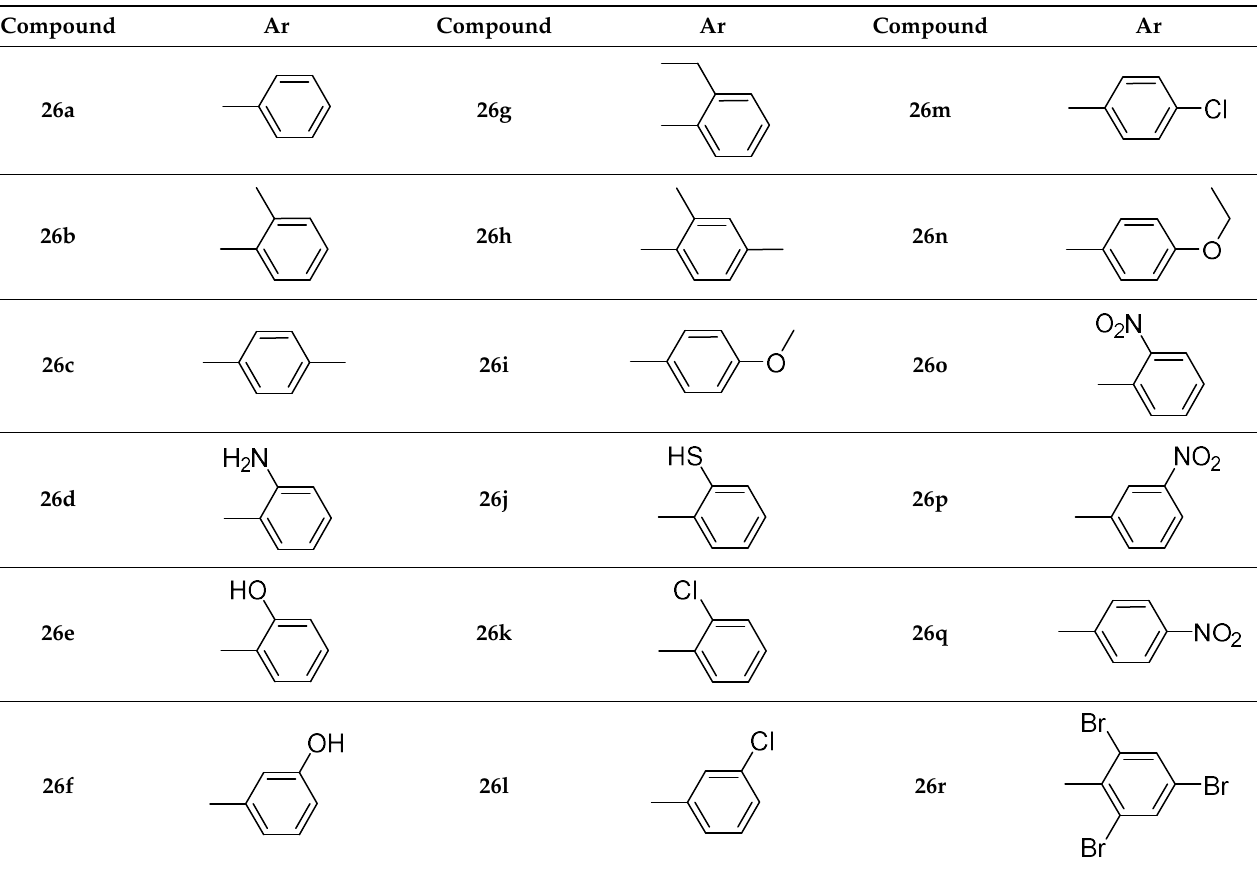
Table 1. List of substituted anilines in 26(a–r) .